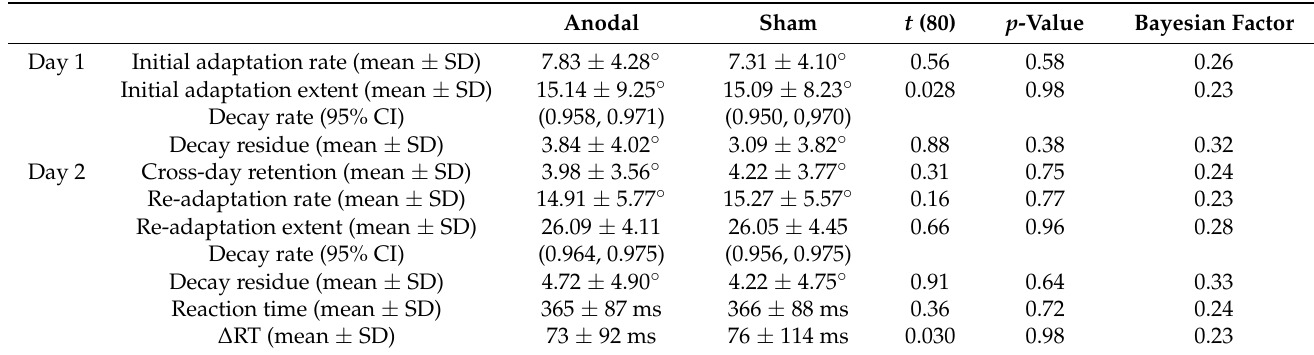
Experiment 2: No evidence of anodal or cathodal ctDCS effect on error clamp adaptation with a small clamp